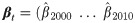
DTO presence and night lights over time.This figure presents estimates of βt=(β^2000…β^2010) from the following regression: ℓ
mst = β
t⋅(DTOmst×T
t)+ξ
m+ζ
t+γ
st+ε
mst, where ℓ
mst is night lights in municipality m, state s, and year t, ξ
m is a full set of municipalities fixed effects, ζ
t is a full set of year fixed effects, DTOmst is an indicator variable that takes the value of one if some DTO is active in municipality m, state s, and year t, γ
st is a state-year fixed effect, ε
mst is an error term clustered at the municipality level.